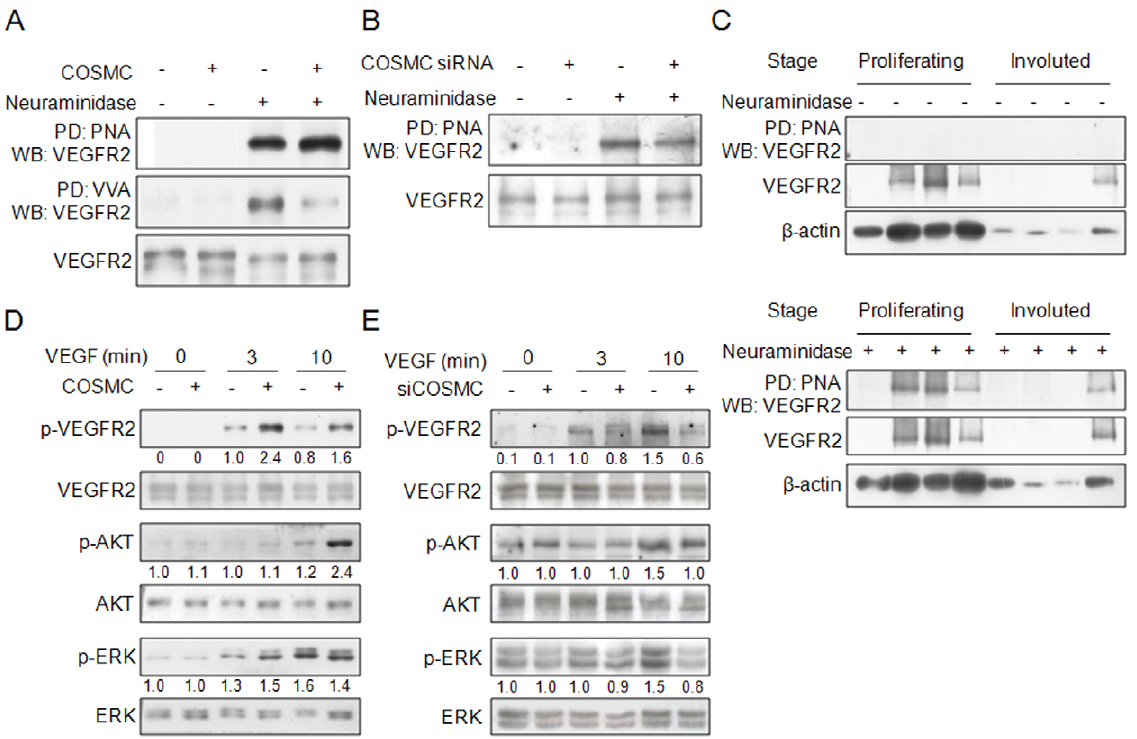
Figure 5. COSMC overexpression modulates O-glycans on VEGFR2. (A) Changes in O-glycans on VEGFR2 in COSMC overexpressing HUVECs. Cell lysates of HUVECs transfected with control or COSMC plasmids were treated with or without neuraminidase, pulled down with VVA or PNA lectins, then immunoblotted with anti-VEGFR2 antibody. b -actin is an internal control. (B) COSMC knockdown in HUVECs decreases binding of PNA to VEGFR2. (C) O-glycans are present on VEGFR2 in human primary hemangiomas. Tissue lysates of proliferating and involuted hemangiomas with ( + ) or without ( 2 ) neuraminidase treatment were pulled down (PD) by PNA and then immunoblotted with anti-VEGFR2 antibody. b -actin is an internal control. (D) COSMC overexpression enhances phosphorylation of VEGFR2 in HUVECs. HUVECs were serum starved for 4 h and then treated with 20 ng/ml of VEGF for different time periods. Phosphorylation of VEGFR2, AKT, and ERK were analyzed by Western blotting. b -actin is a loading control. Representative images from two independent experiments were shown. Signals on Western blots were quantified by ImageQuant5.1. (E) COSMC knockdown suppresses phosphorylation of VEGFR2 in HUVECs. Signals on Western blots were quantified by ImageQuant5.1.